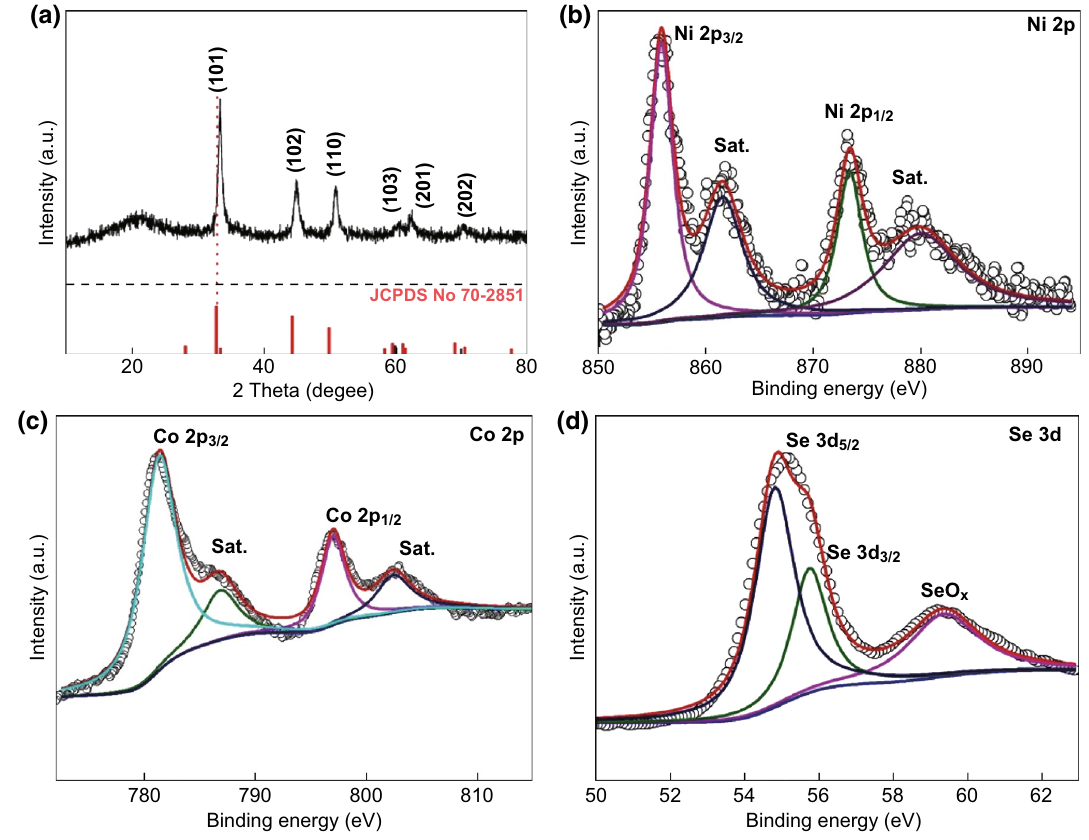
Fig. 3 a XRD pattern of the Ni 0.2 Co 0.8 Se nanocages. The core‑level XPS spectra for the b Ni 2 p , c Co 2 p , and d Se 3 d electrons of Ni 0.2 Co 0.8